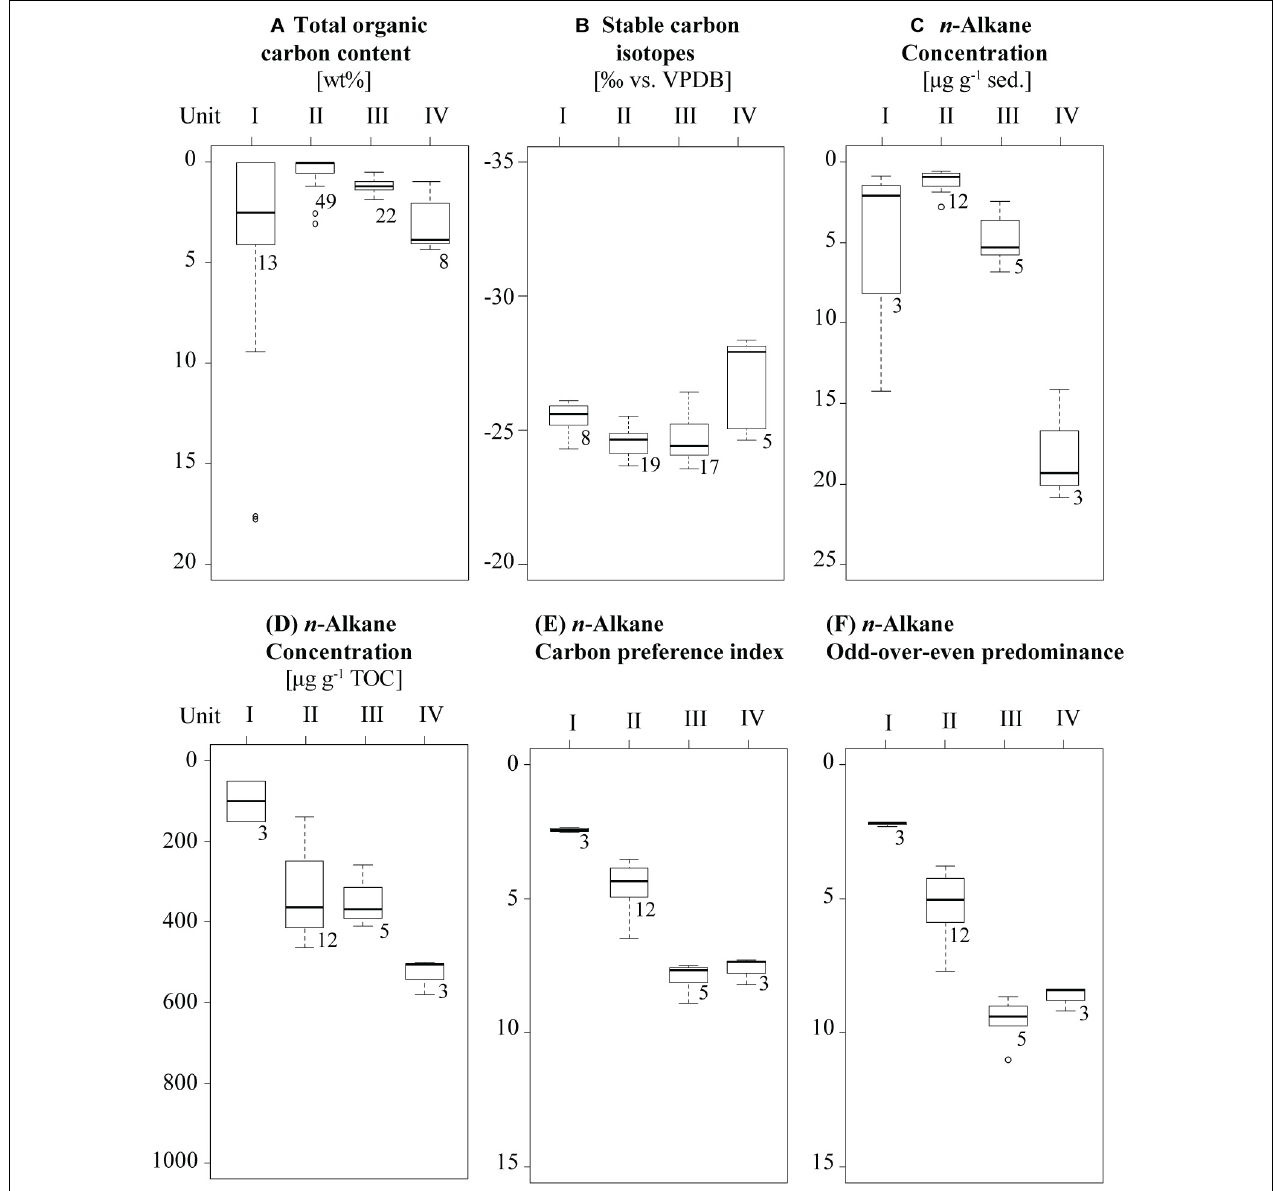
FIGURE 8 | Box-whisker plots of biogeochemical and biomarker parameters of Goltsovoye Lake sediment core PG2412. (A) Total organic carbon content, (B) stable carbon isotopes, (C) n -alkane concentration per g sed., (D) n -alkane concentration per g TOC, (E) n -alkane carbon preference index, and (F) n -alkane odd-over-even predominance. Samples sorted according to n -alkane clustering. Box-whisker plots according to Tukey with outliers outside of 1.5 interquartile range (IQR). IQR = Q 3 -Q 1 , range between upper and lower quartiles. Numbers denote sample